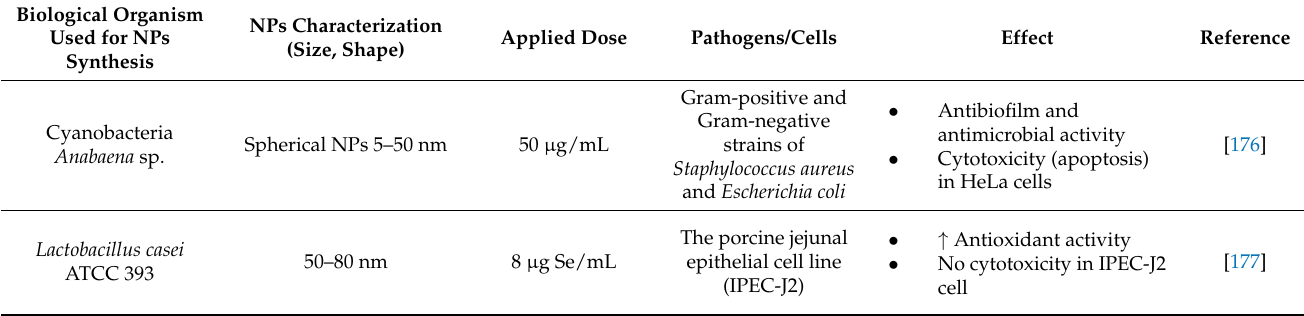
Table 4. Effects of biogenic SeNPs tested in vitro with potential use in